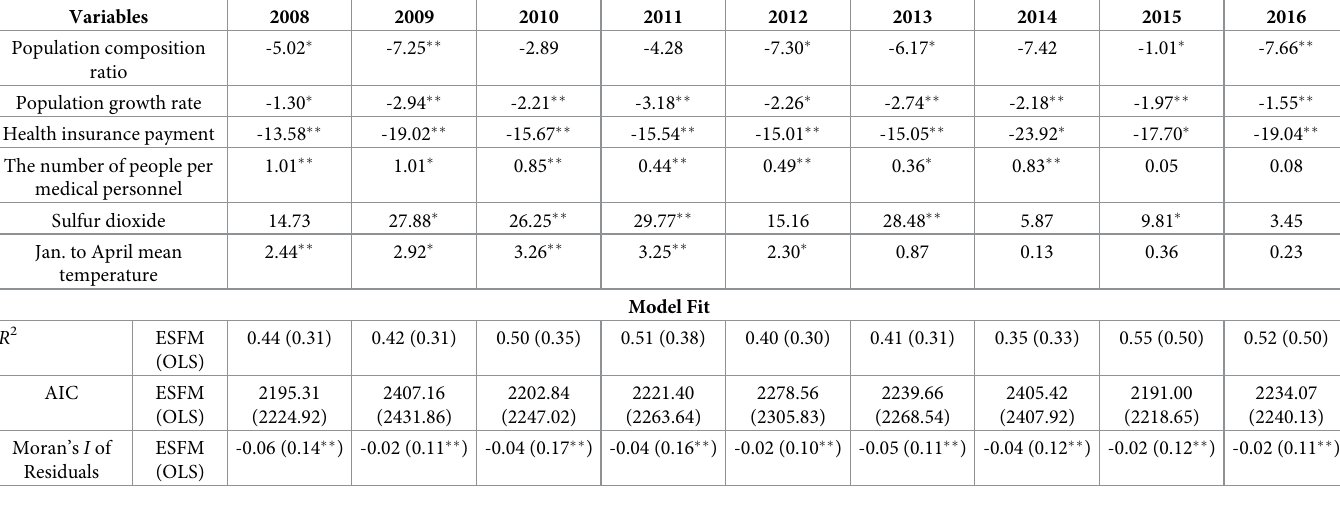
Table 2. Estimation results of the eigenvector spatial filtering